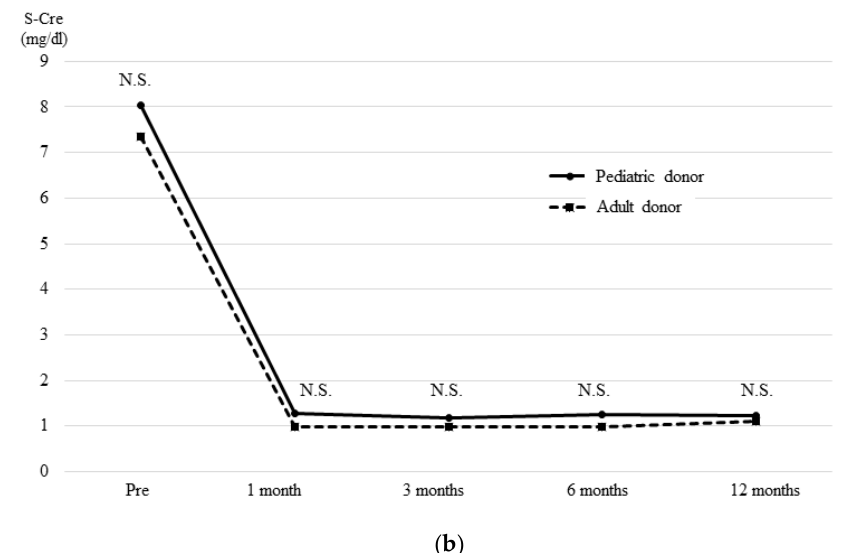
Figure 3. The time course of the HbA1c (a) and serum creatinine (b) levels after transplantation. The median preoperative HbA1c level of the recipients in the PD group was significantly higher than that in the AD group. The median HbA1c at one month post-transplantation was significantly higher in the PD group. However, there were no differences between the two groups after three months, with good values maintained in both groups. There were no differences between the two groups in the time course of the median serum creatinine level in cases in which simultaneous pancreas and kidney transplantation was performed, and a good renal graft function was maintained in all cases.